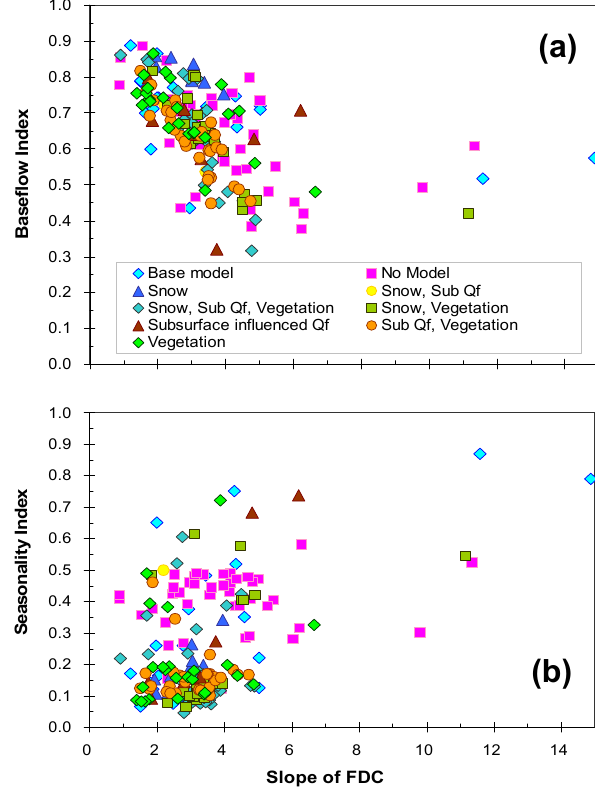
Fig. 11. Relationship between baseflow index (a) and seasonality index (b) and total streamflow FDC slopes (grouped by dominant model